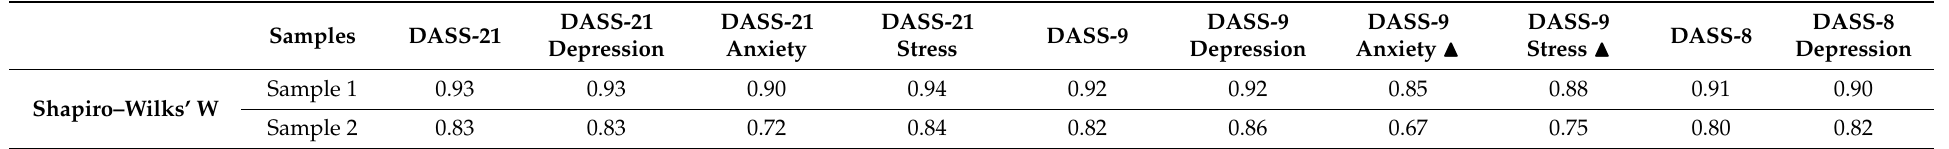
Table 3. Comparison of the normality of the Depression Anxiety Stress Scale 21 (DASS-21) and its subscales with that of the DASS-9/DASS-8 and their subscales.